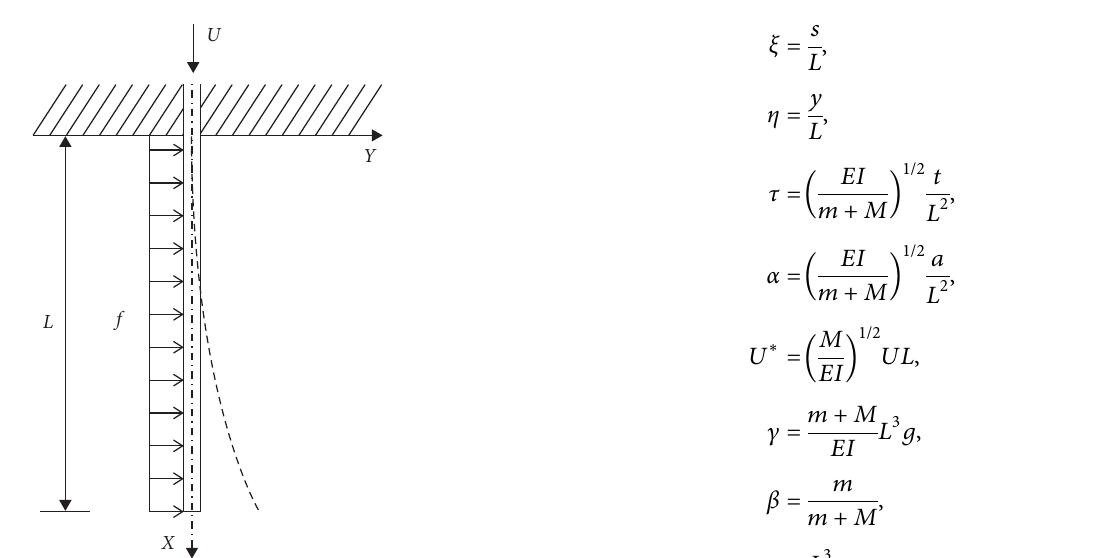
Figure 1: The dynamic model of a cantilevered pipe conveying pulsating fluid is